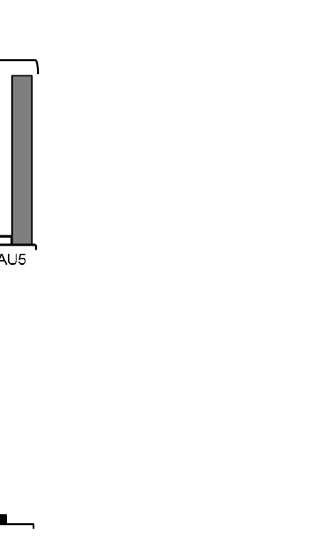
Figure 2. Expression of vTR harboring the mutant template (AU5) decreases cell proliferation of an avian cancer cell line. A) Analysis of telomerase activity in primary CEC cultures, the chicken fibroblast cell line DF-1 with or without TERT expression, and the quail QT35 cancer cell line using TRAP assays. TRAP products representing telomere elongation and internal control (IC) are indicated. B) RT-qPCR of vTR copies in polyclonal empty vector, vTR or AU5 QT35 cell lines induced with 1 m g/ml doxycycline (Dox) for 3 and 5 d or left uninduced. Data is shown as relative quantitation (RQ) of vTR copies relative to quail GAPDH RNA copies that served as an endogenous control. C) Percent (%) confluency of vector, vTR, and AU5 cell lines over the course of 31 d. Results are shown as means and standard errors of three independent experiments. P values were determined between each group using Student’s t tests.